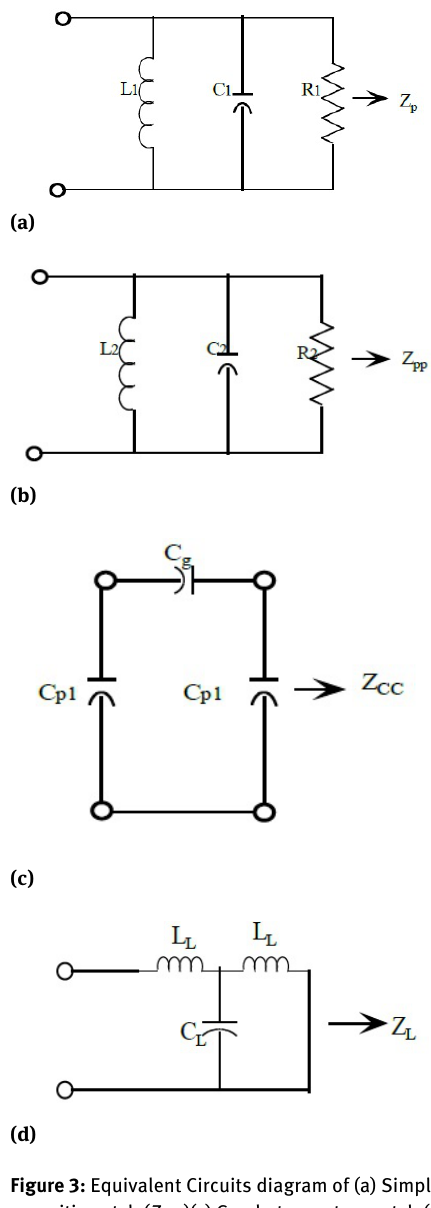
Figure 3: Equivalent Circuits diagram of (a) Simple patch ( Z p ) (b) parasitic patch ( Z pp )(c) Gap between two patch ( Z cc ) (d) Microstrip line patch ( Z L )